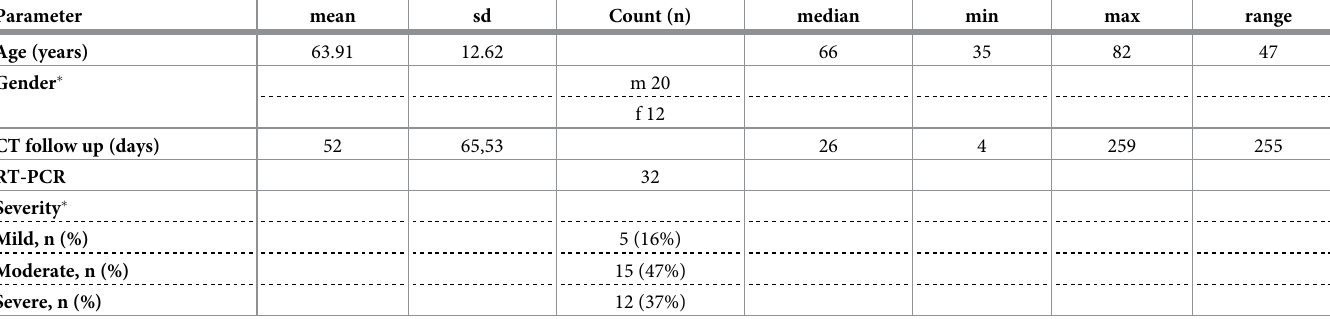
Table 1. Demographic characteristics of n = 32 patients with RT-PCR proven coronavirus disease.